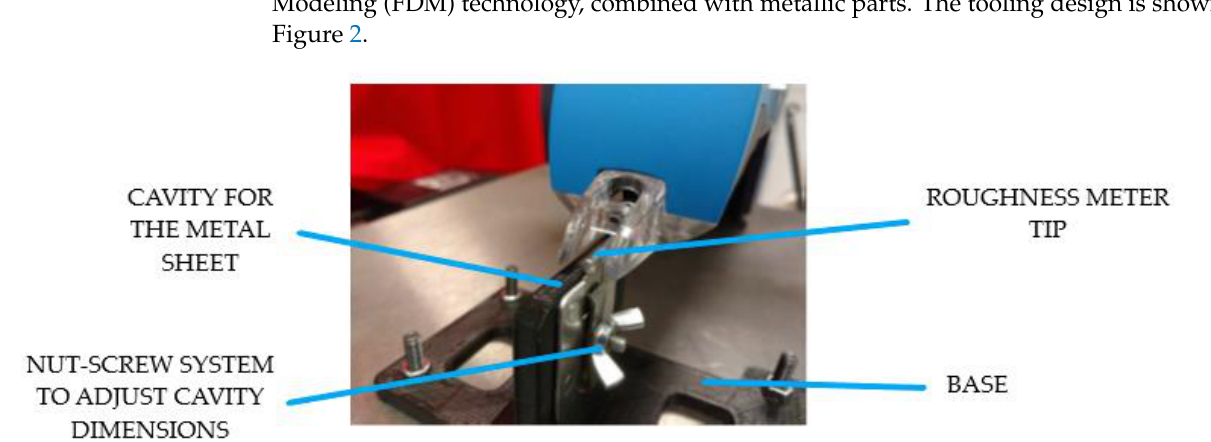
Table 2. Levels for the different